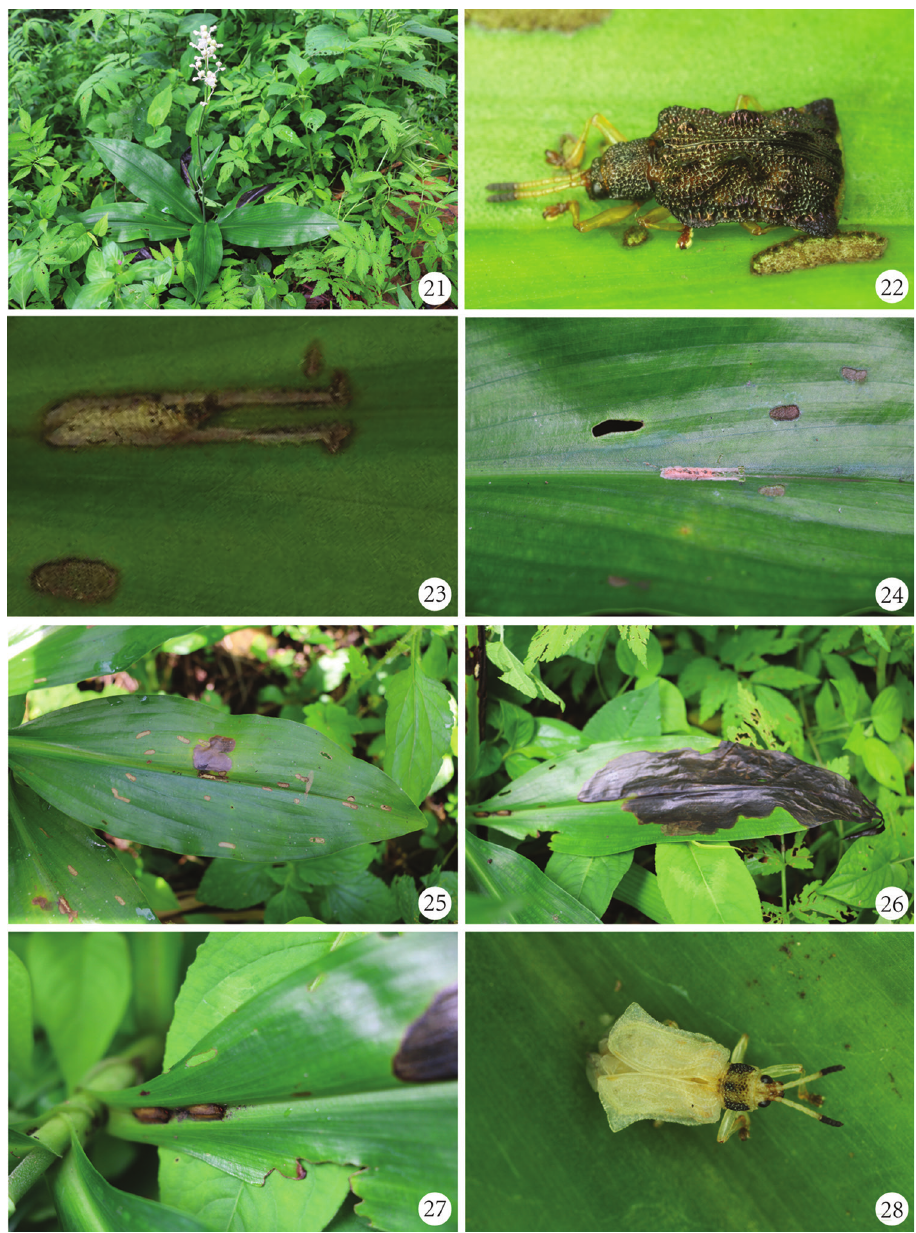
22 Adult of P. champaka and its feeding channel 23-24 An egg sheath of P. champaka which laid and lo- cated on the mid-rib of upper surface of a leaf 25 A leaf with new mine of hatching larvae of P. champaka and some linear feeding channels of adults 26 Large larval mine of mature larvae 27 Two pupal mines of P. champaka located at the base of petiole on the upper surface 28 Freshly emerged